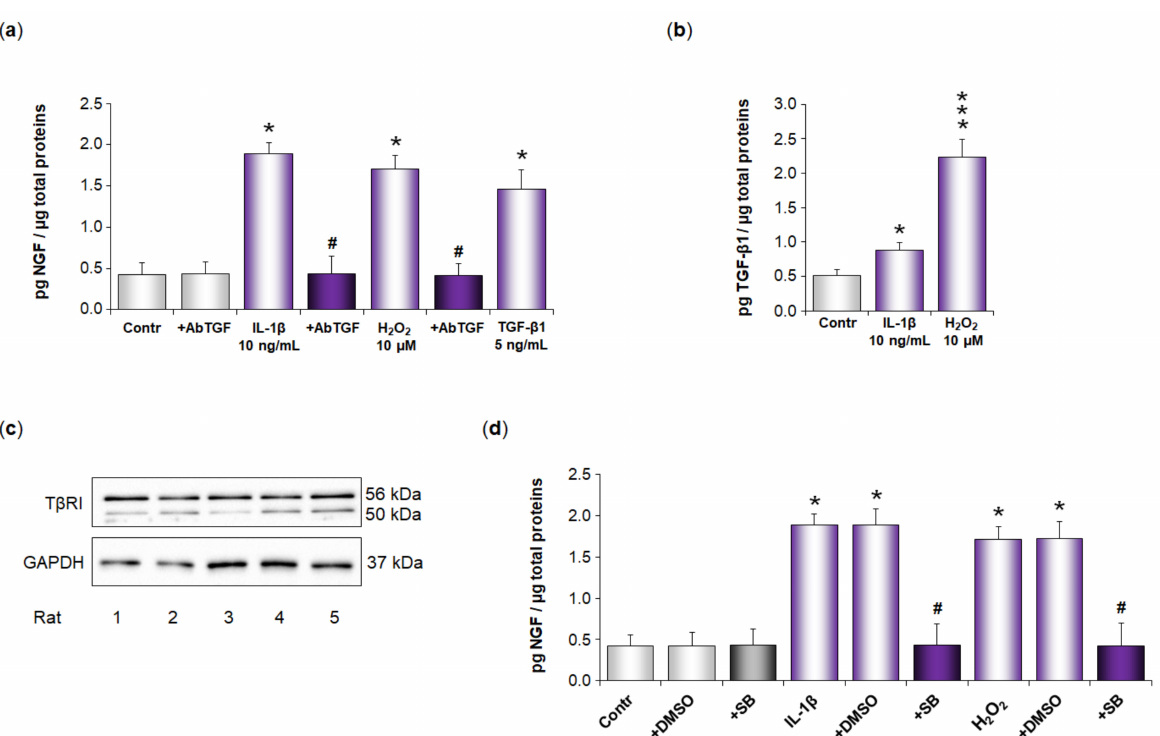
Figure 8. Role of TGF- β 1 in IL-1 β - or H 2 O 2 -induced increase in NGF secretion by rat whole pul- monary arteries. ( a ) NGF secretion by rat whole pulmonary arteries was assessed in the absence or presence of interleukin-1 β (IL-1 β , 10 ng/mL, 24 h), hydrogen peroxide (H 2 O 2 , 10 µ M, 24